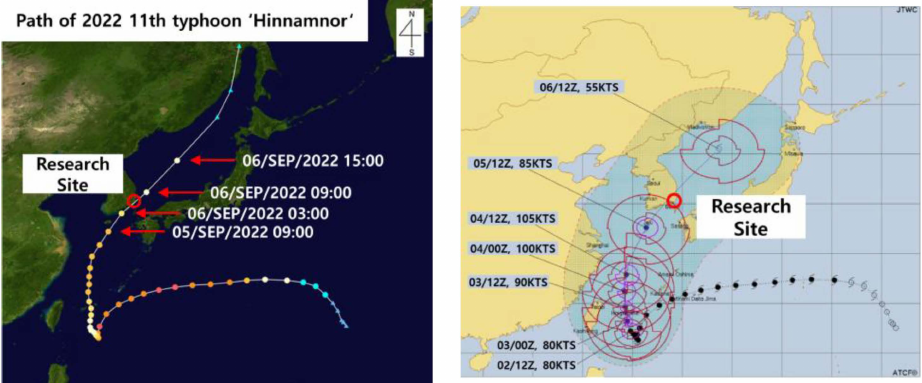
Figure 1. Spatiotemporal path of Typhoon Hinnamnor in relation to the study site